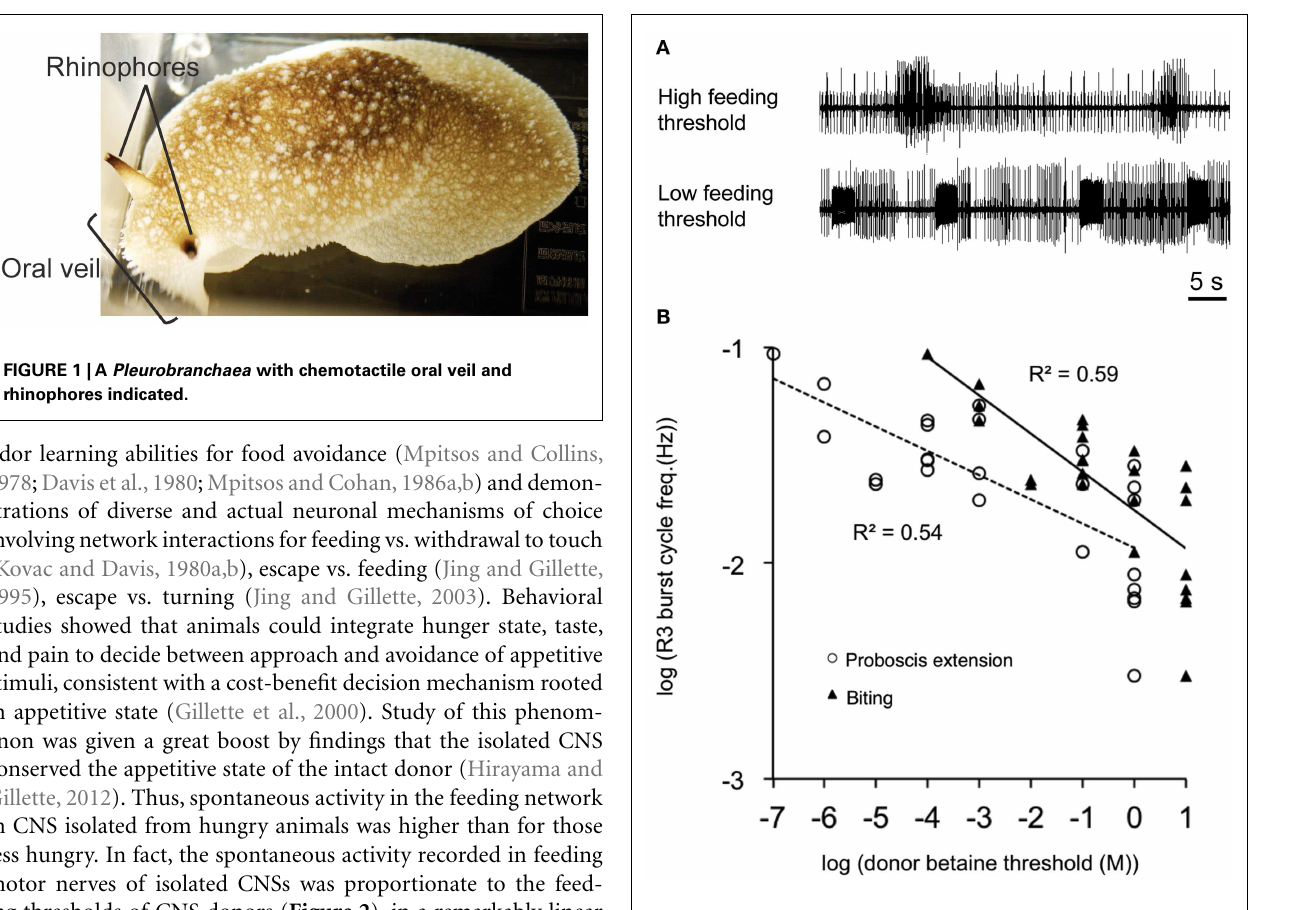
FIGURE 2 | Conservation of appetitive state in the isolated CNS. Spontaneous feeding nerve burst frequency correlated with donors’ sensory feeding thresholds to the appetitive stimulant betaine (trimethylglycine). (A) Spontaneous burst frequency recorded from buccal motor nerve R3 of isolated CNSs was less from high-threshold donors than from low-threshold donors. (B) R3 burst frequency was an approximately linear function of donor feeding thresholds on a log–log plot ( n = 25; R 2 = 0.54 and 0.59 for proboscis extension and biting, respectively). Line fits were by least squares.Three high-threshold donor CNSs did not show burst patterns in R3 and were excluded from the figure. From Hirayama and Gillette